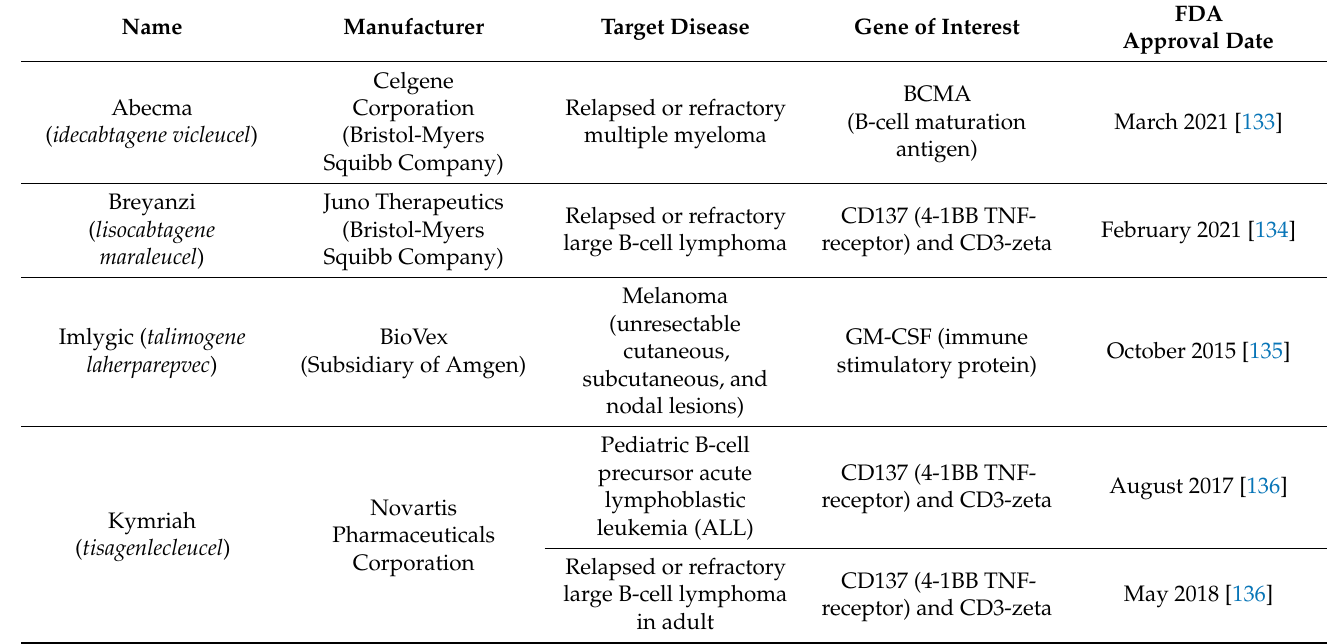
Table 2. Commercially Available Gene Therapies in the U.S. in Alphabetical Order (2021)